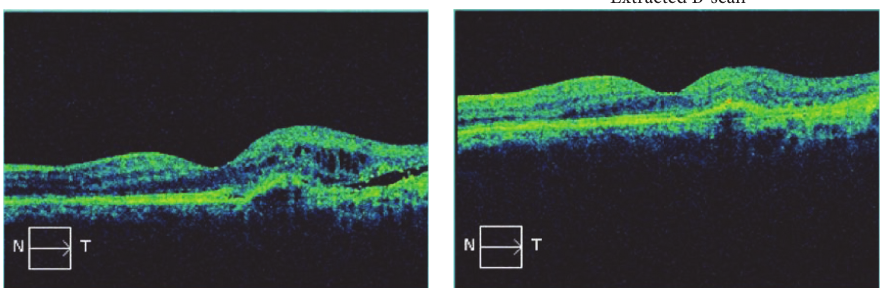
Figure 4: Macular change map of the left eye, showing complete resolution of intraretinal fluid and subretinal fluid in the parafoveal area at the 6th month of follow-up